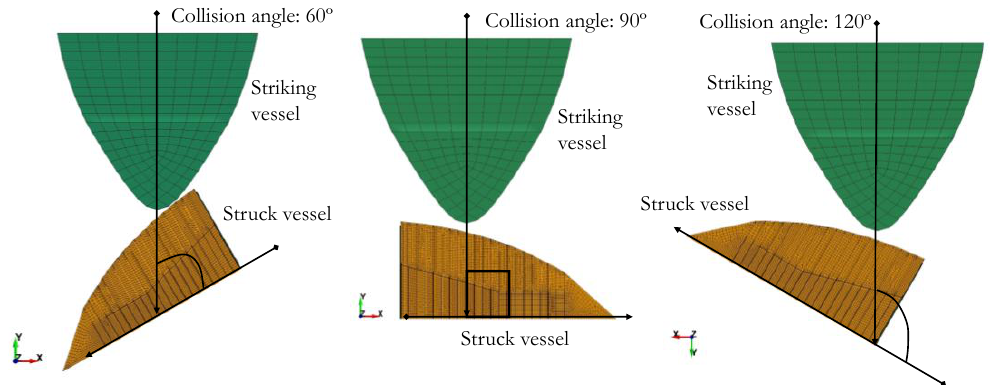
Figure 3. A variety of collision angle applied to the scenarios.